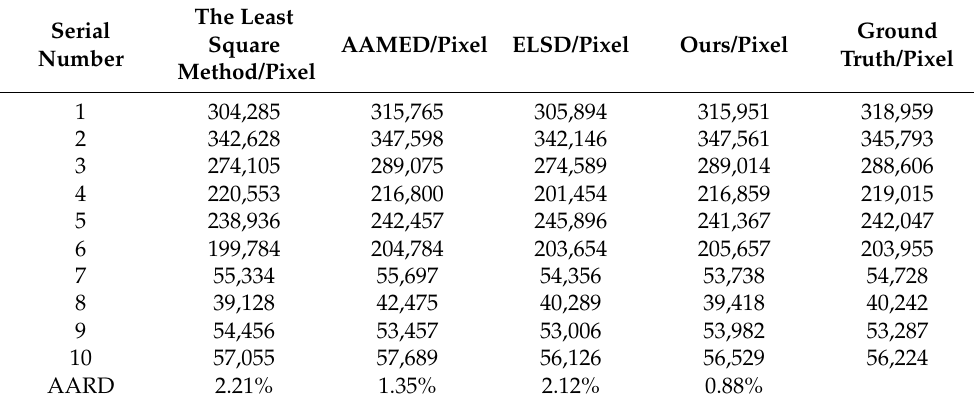
Table 6. Measurement results of the projected area of different grape particle contours by different algorithms.